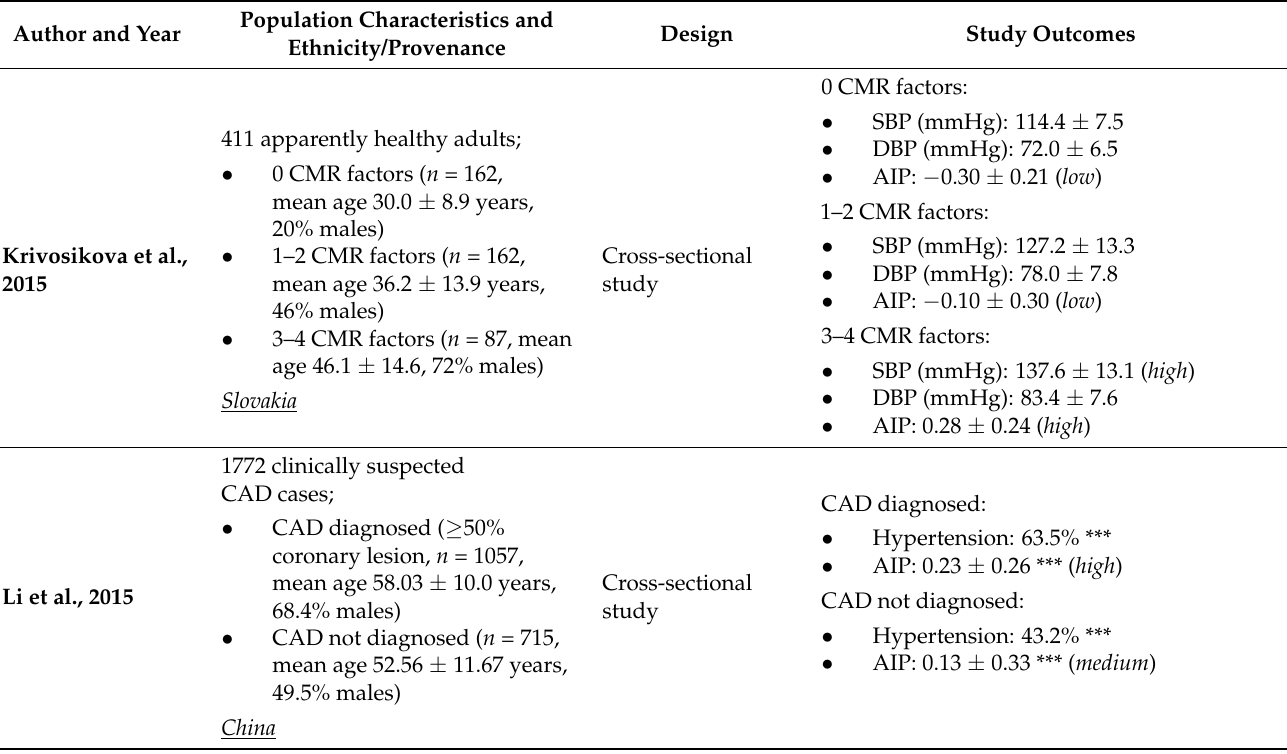
Table 6. Outline of the studies interlinking blood pressure and AIP. Author, year, subject characteris- tics, study design, primary outcomes, and other study outcomes of interest (SBP, DBP, and % of partic- ipants suffering from hypertension) are presented for each study where available